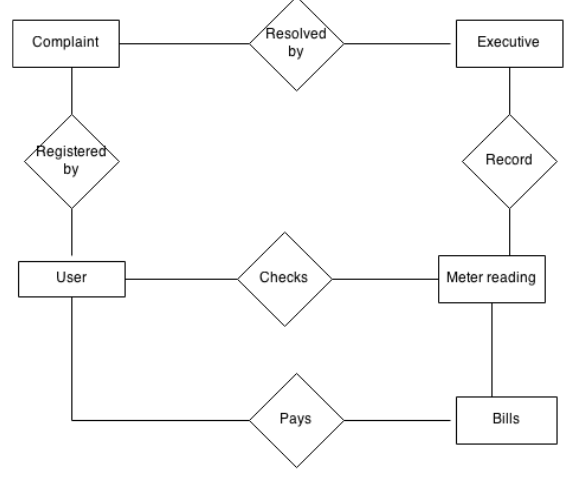
Figure 6. Entity relationship at broad level